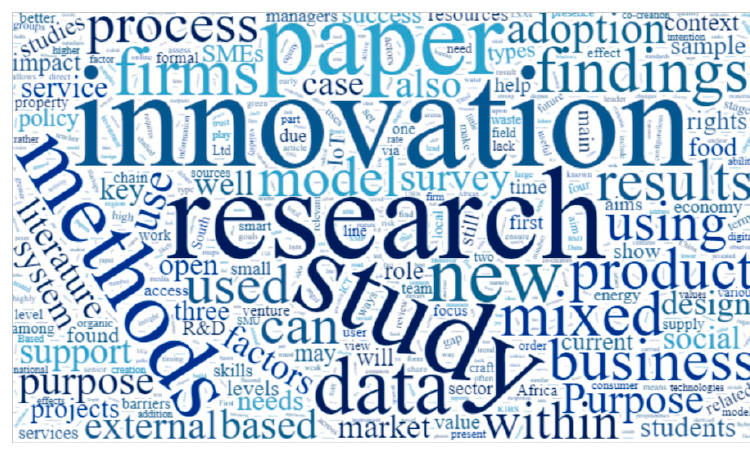
Figure 4. Identification of keywords in a tag cloud representation (source: own study).